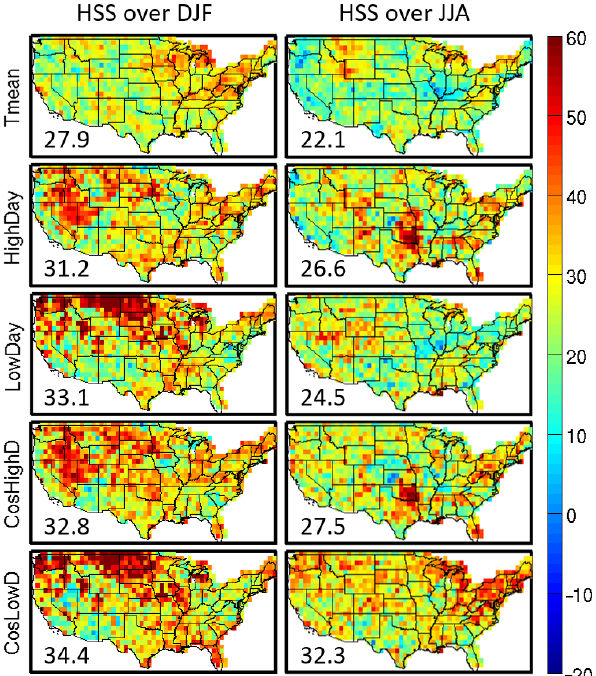
Figure 6. HSS of 30-day (from top to bottom columns) T mean , HighDay, LowDay, CosHighD, and CosLowD from (from left to right rows) the CFSv2 daily hindcasts during DJF (left) and JJA (right). The number in the bottom left is the average.